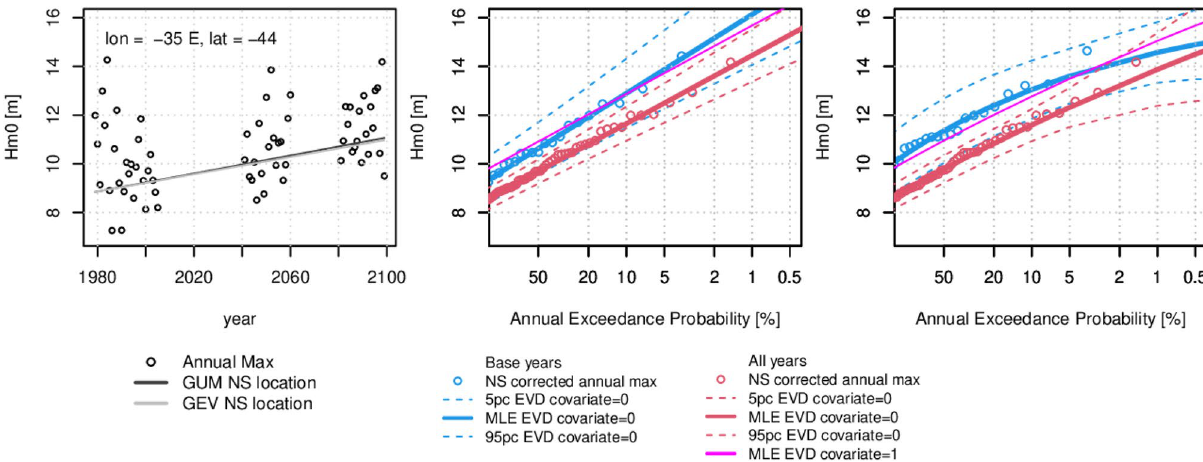
Figure 4. EVD fits to the GFDL-CM3 model output at an example location south of Tasmania, Australia. Left is time series of annual max Hm0 with the trend line of nonstationary (NS) location parameter for the Gumbel and GEV fits. Centre plot is Gumbel EVD for the baseline and full RCP85 periods including the MLE and 90% confidence intervals for the covariate equals zero at 1979 and the MLE for the covariate equals one at 2100. Right is same as the centre but for a GEV EVD. Created using the R statistical software version 4.0.2 22 .